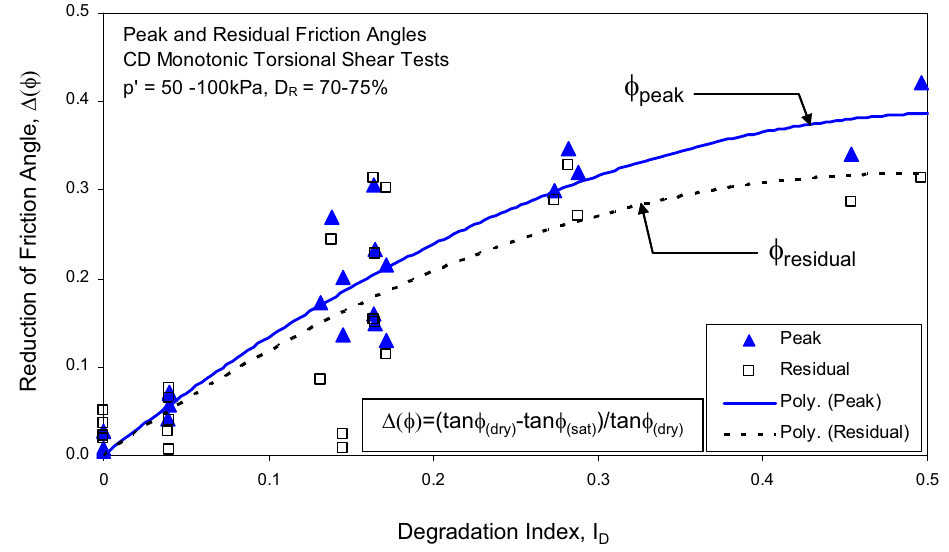
Fig. 13. Proposed relationship for assessment of time-dependent strength reduction of crushed rocks due to water-induced granular decom-